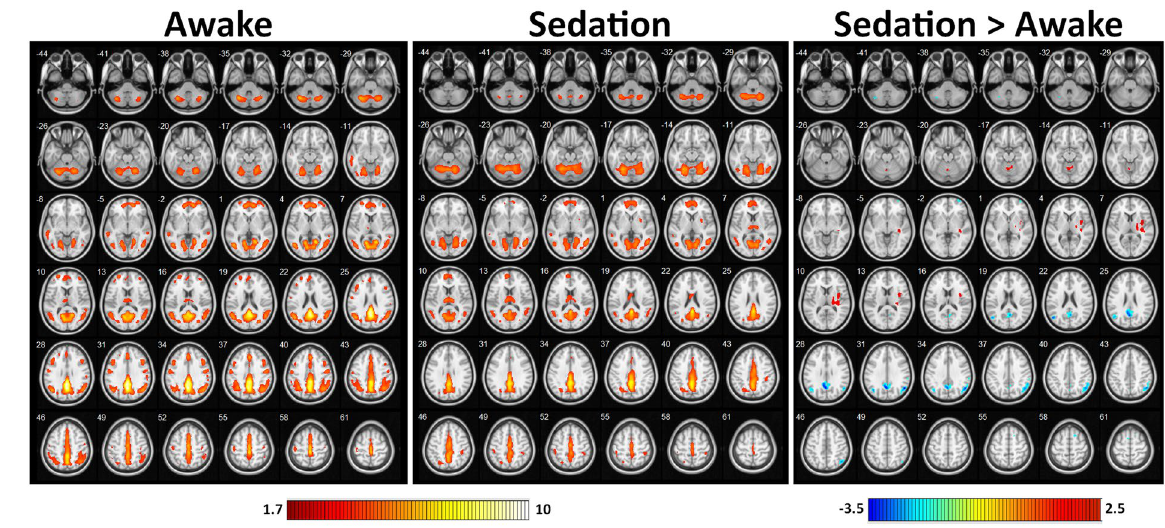
Figure 2. Whole brain group mean image of dynamic functional connectivity maps during the awake state, sedation and the differences between two conditions. The regions which showed significant decreased connectivity prominently involving the default mode network and peri-rolandic regions is represented in blue and the regions with increased connectivity involving cerebellum, thalamus and basal ganglia is depicted in red in the last column which depicts effects of sedation.